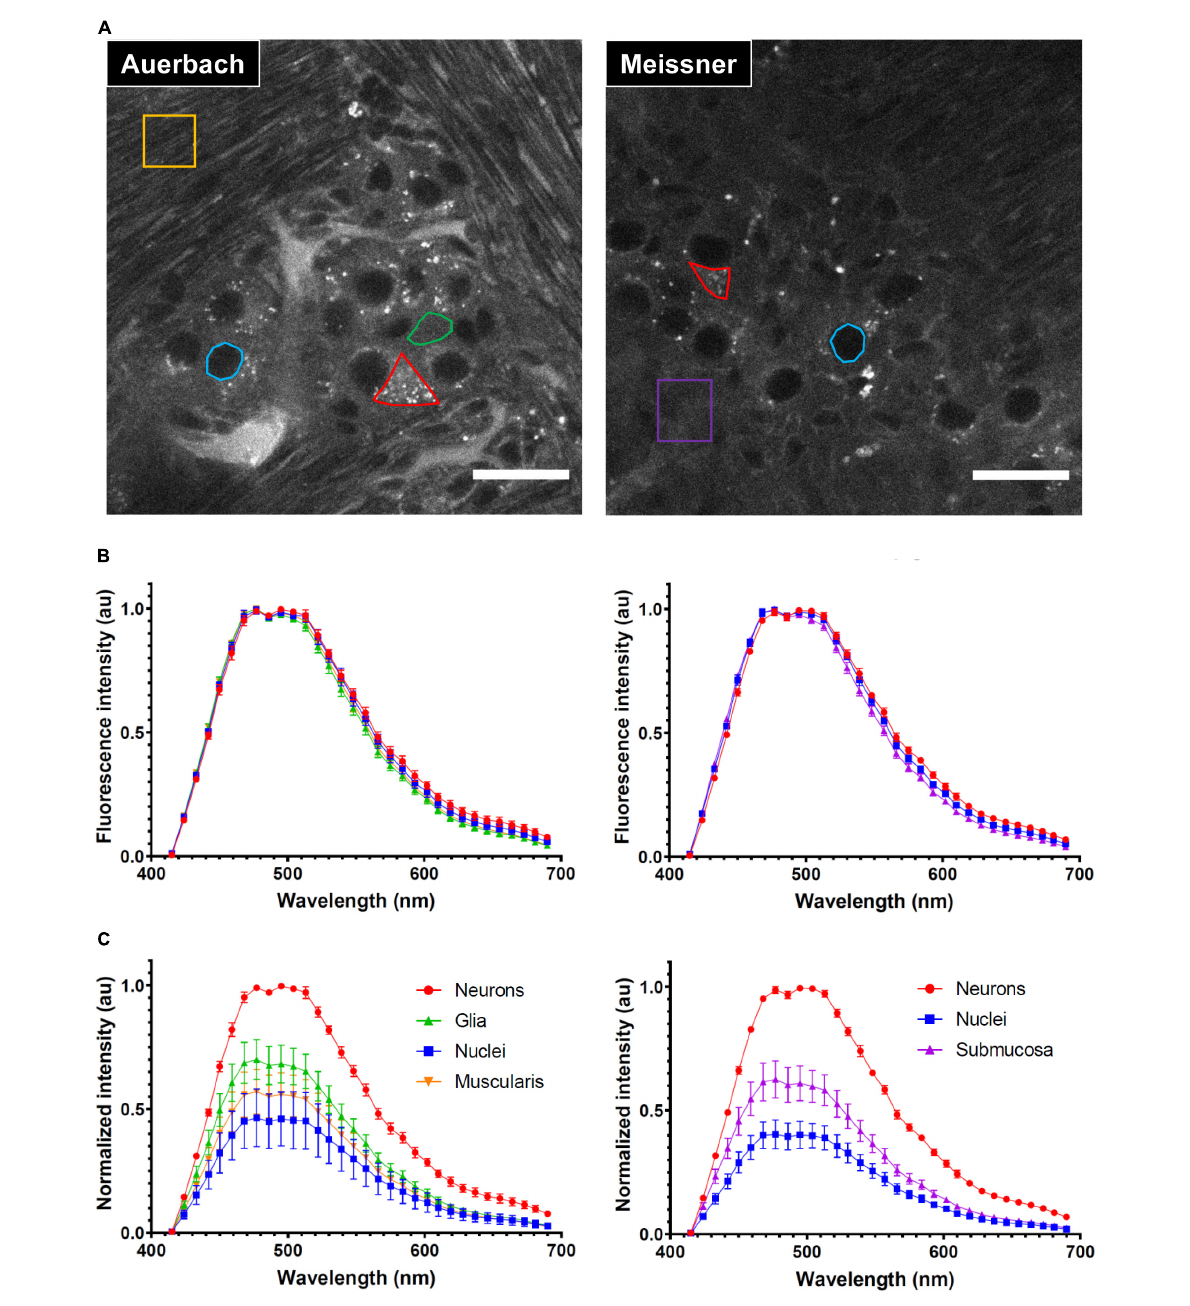
FIGURE4 Characterization of the autofluorescence (AF) of the enteric nervous system (ENS). (A) Autofluorescence images taken at the level of the Auerbach’s (left) and Meissner’s (right) plexus . Representative regions of interest (ROI) used for spectral characterization are shown in color (red: neurons cell bodies, green: enteric glia cytoplasm, blue: neurons nuclei, yellow: muscularis , purple: submucosa ). Scale-bars: 25 µ m. (B) Spectral signatures of the ROI depicted in panel (A) at the level of the Auerbach’s (left) and Meissner’s (right) plexus . (C) Relative fluorescence intensity of the ROI depicted in panel (A) at the level of the Auerbach’s (left) and Meissner’s (right) plexus . Error-bars: SD.